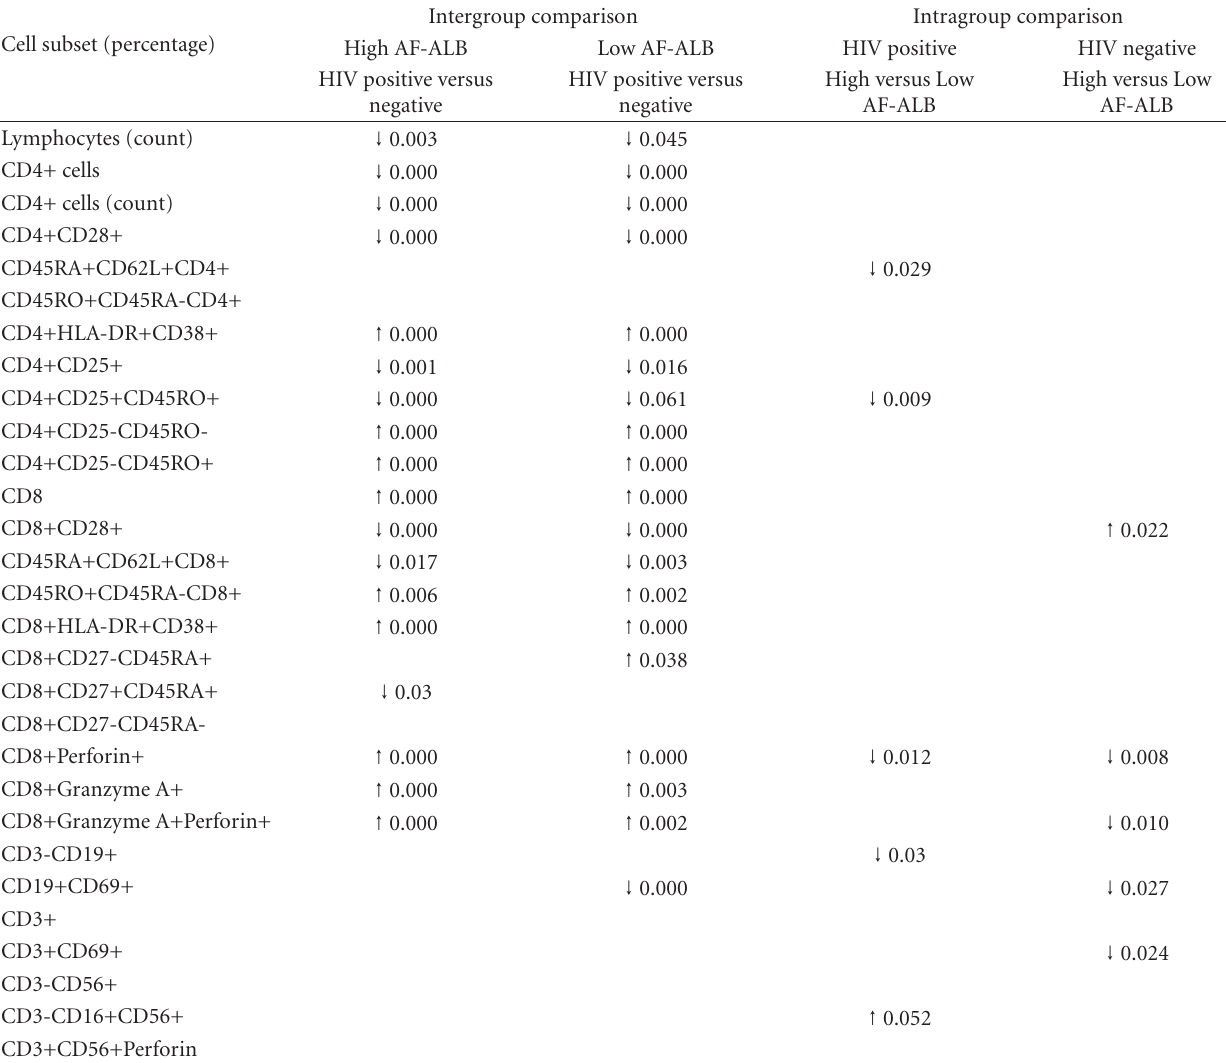
Table 2: Summary of the immune indices in which significant di ff erences ( P value) were identified by intra- and intergroup comparisons among high and low aflatoxin B1 albumin adduct (AF-ALB) and HIV positive and HIV negative participants. Cell subset